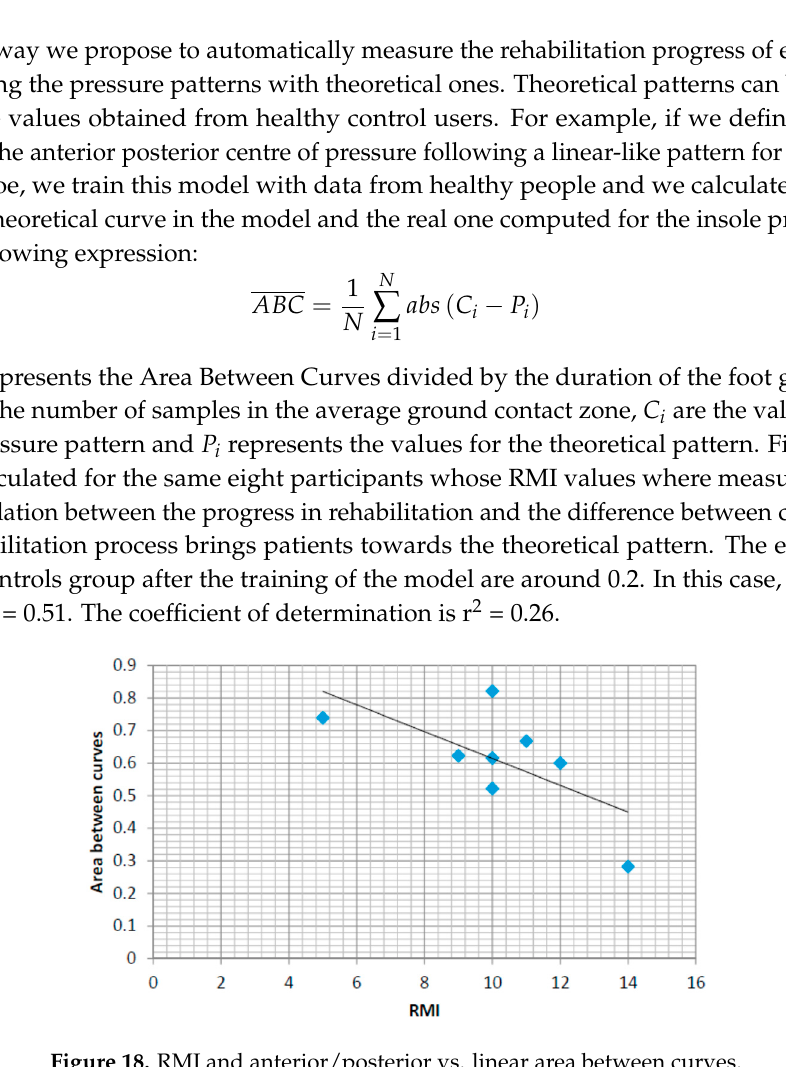
Figure 17. RMI and anterior/posterior amplitude in the normalized pressure pattern.